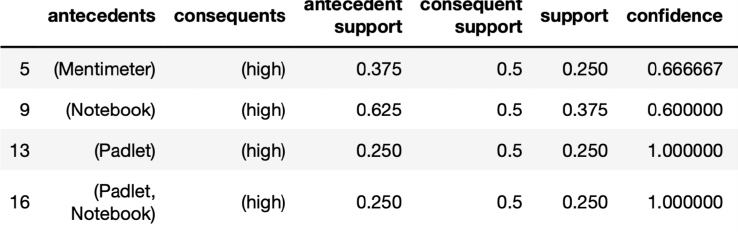
Figure 8. Output of the algorithm in Listing